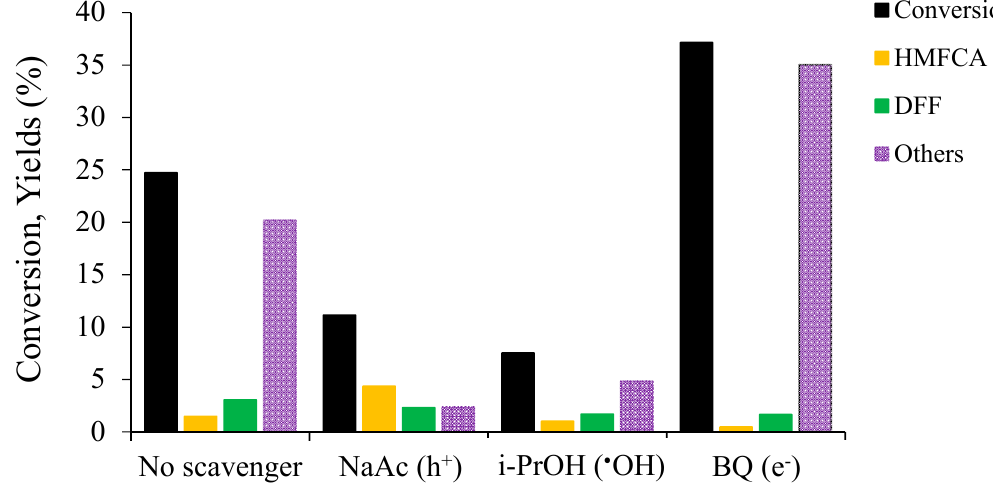
Figure 9. Photocatalytic performance of TiO 2 -m in presence of different scavengers. NaAc: Sodium Acetate; i-PrOH: 2-Propanol; BQ: BenzoQuinone. Reaction conditions: t = 1 h, T = 30 °C, P = 1 atm O 2 , m cat = 20 mg, V = 20 mL, [HMF] 0 = 5 × 10 − 4 mol/L, [Scavenger]/[HMF] = 9.